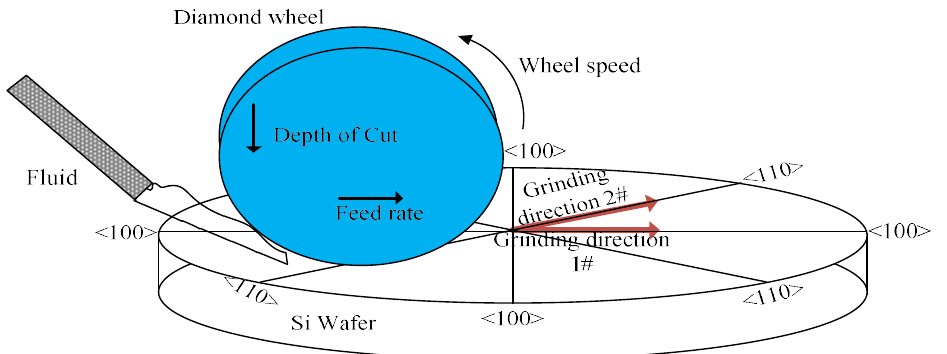
Figure 1. Schematic of trials of grinding along <100> and <110> orientation. Table 1. Experimental parameters and levels.